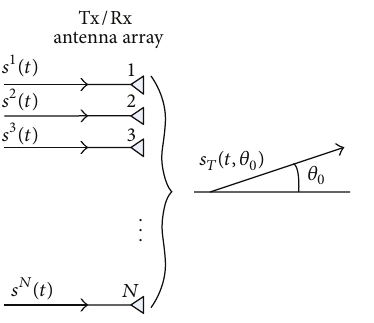
Figure 1: MIMO transmission.